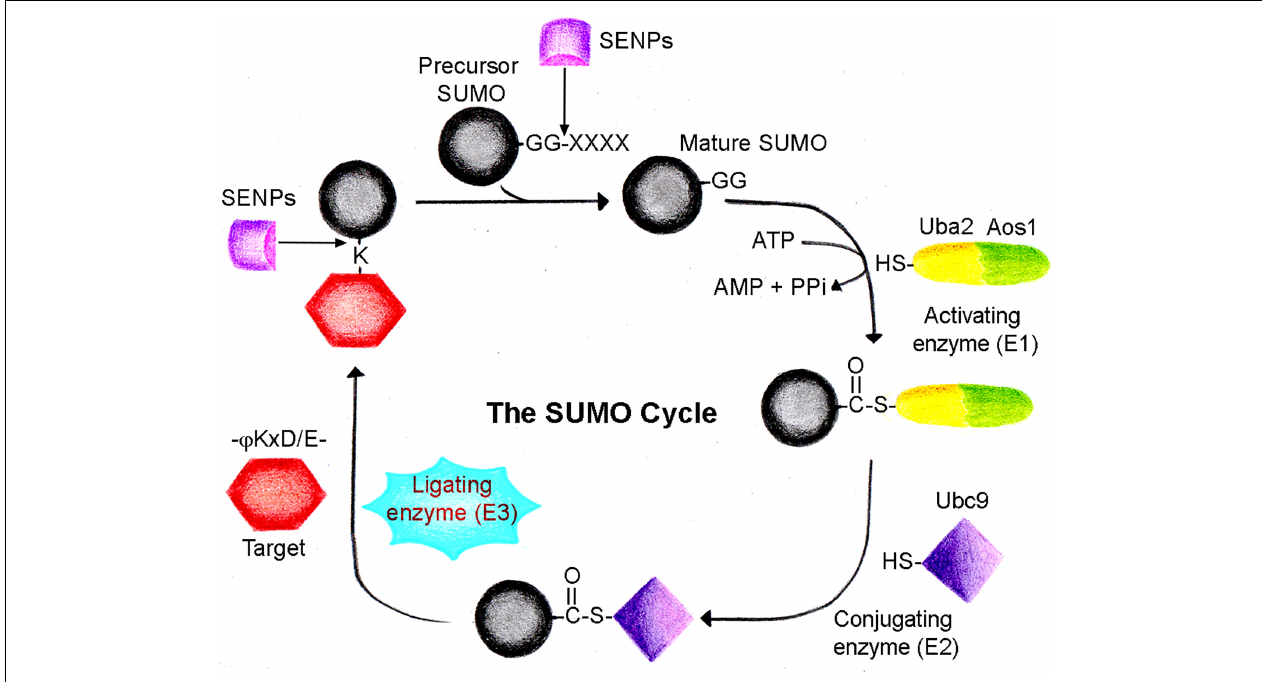
FIGURE 1 | The SUMO cycle. SUMO is conjugated to a target protein following a cascade of enzyme-catalyzed reactions. Precursor SUMO is processed by sentrin proteases (SENPs) to generate the mature SUMO form. Heterodimeric SUMO activating enzyme (Uba2/Aos1, E1) utilizes ATP to form a thioester complex with mature SUMO. In the next step, SUMO is transferred to the conjugating enzyme (Ubc9, E2), forming another thioester complex. Eventually, SUMO is conjugated to the target lysine residue often present in a – ψ KxD/E- motif with the dispensable use of ligating enzyme (E3). The SUMO cycle completes when conjugated SUMO is recycled again by SENP family